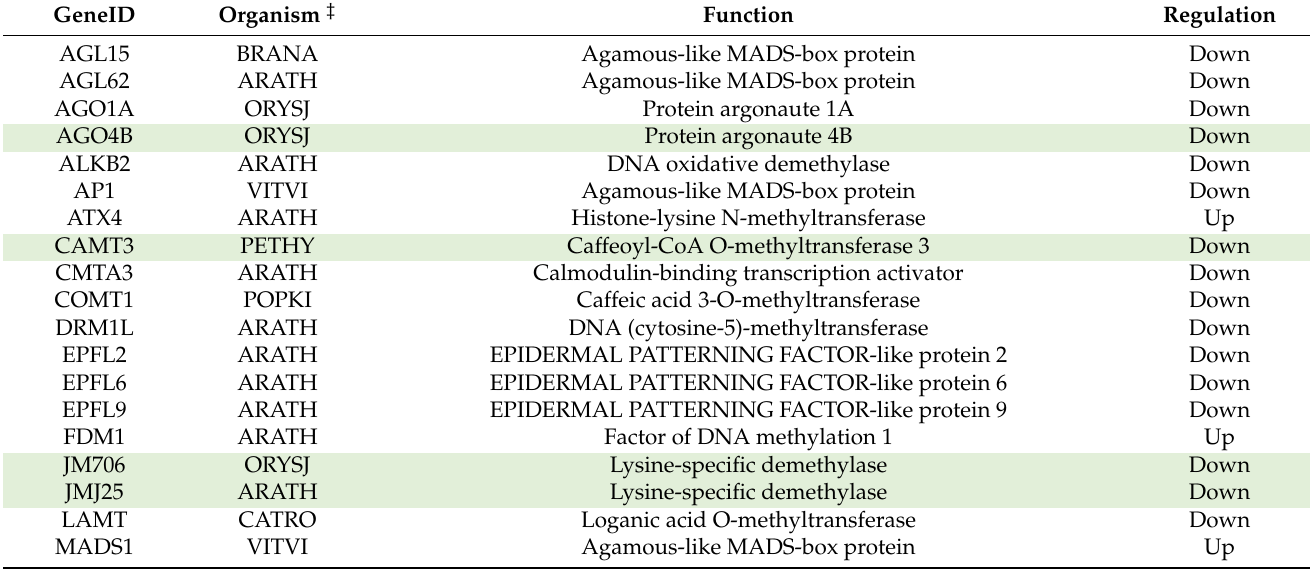
Table 4. List of differentially expressed genes related to DNA methylation in R. kuepferi leaves. Annotation is according to UniProt. The genes which are highlighted are employed as genes of interest (GOIs) for the real-time qRT-PCR. GeneID